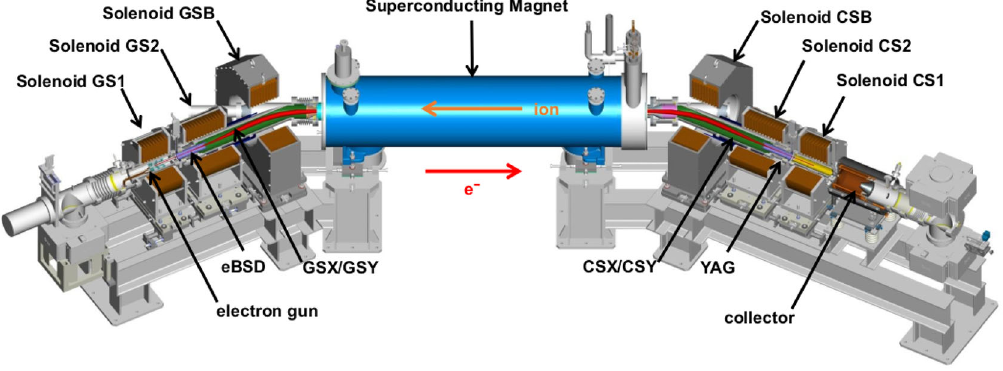
FIG. 1. Schematic layout of one of the RHIC electron lenses